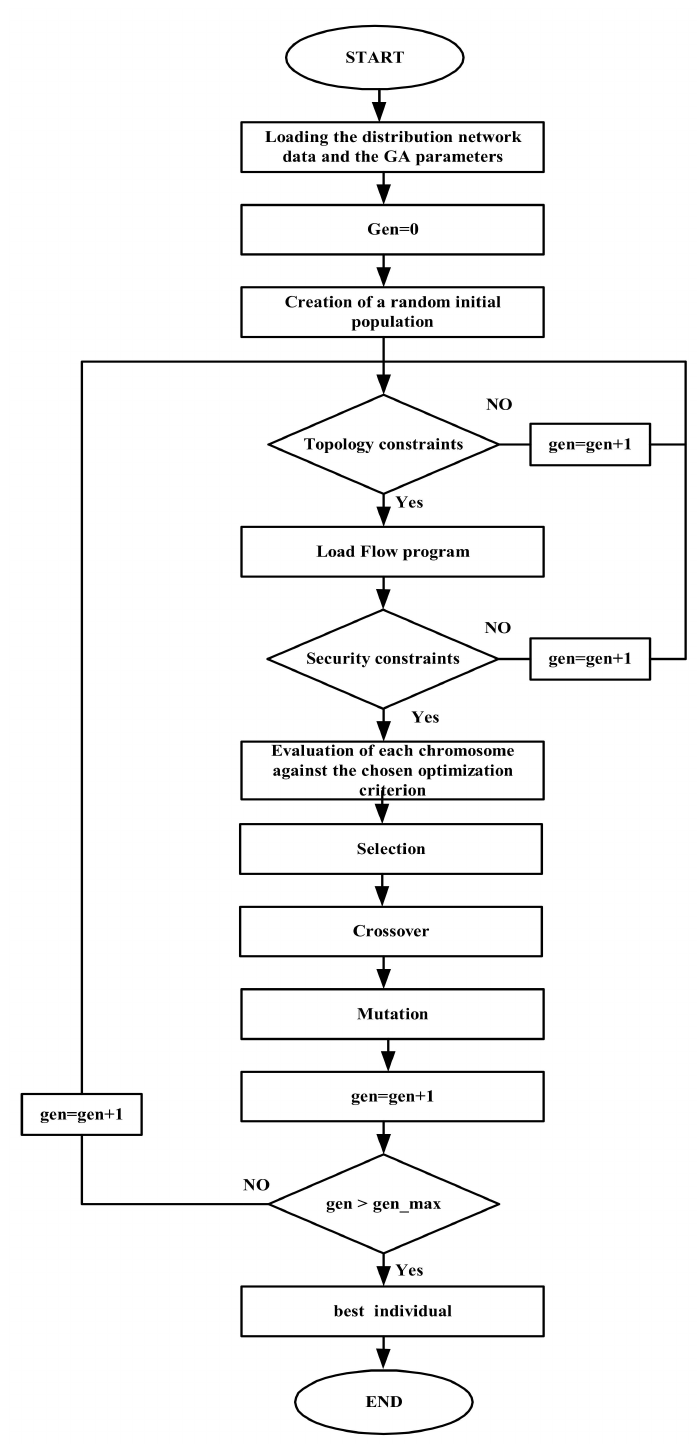
Figure 3. Flowchart of the genetic algorithm